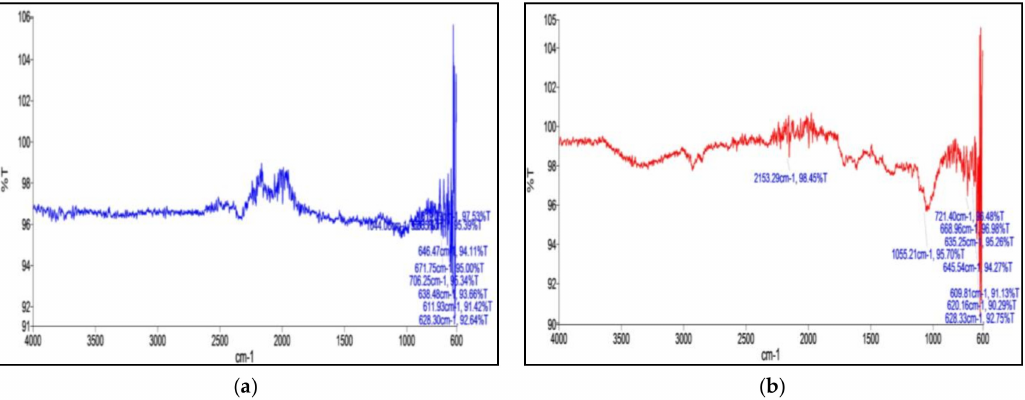
Figure 3. FTIR Spectra of nanoconjugates formed from ( a ) aqueous extract and ( b ) methanolic